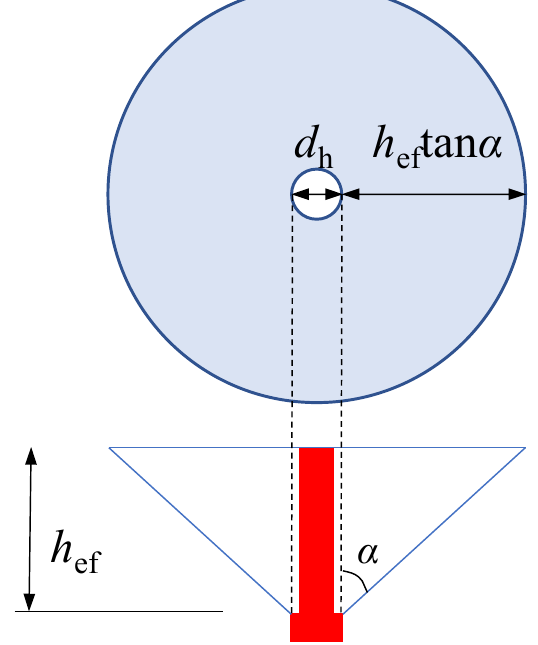
Figure 18. Idealized concrete cone and its projected area.